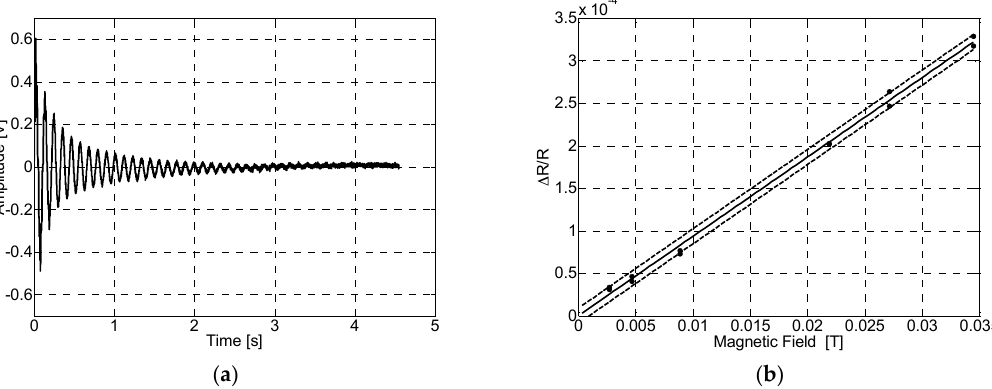
Figure 2. ( a ) Impulse response of the beam; ( b ) Sensor response (driving current of 20 mA @ 9.1 Hz).